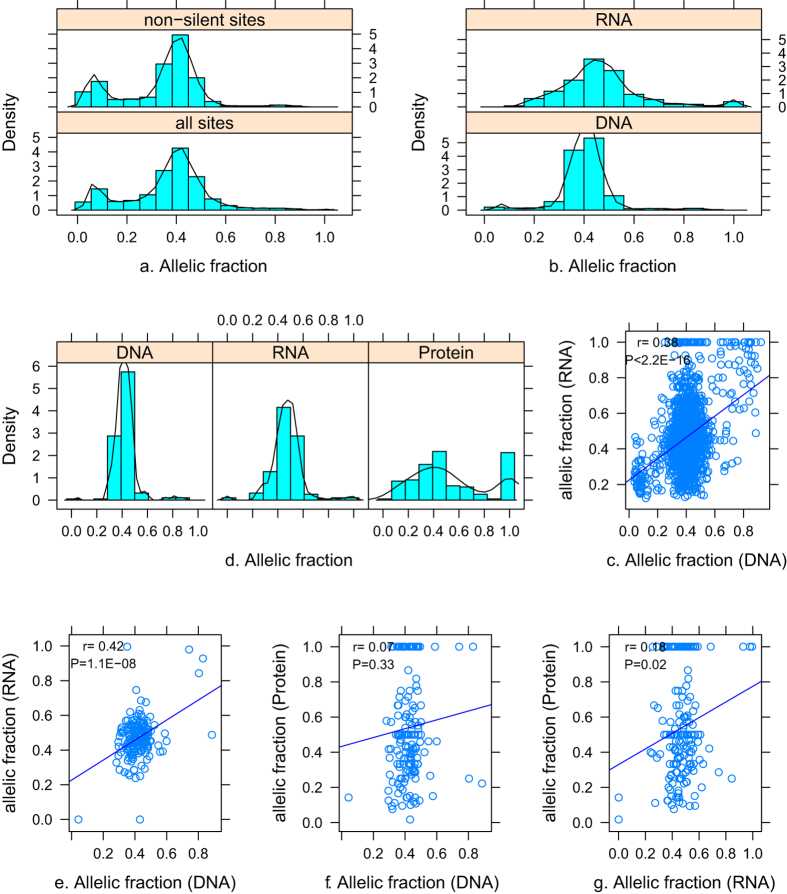
Distribution of the allelic fraction.(a) The allelic fraction of all identified somatic mutations (all sites) and non-silent sites identified by WES. The distribution of allelic fraction between all sites and non-synonymous sites differed significantly (Kolmogorov-Smirnov test, P < 2.2 × 10−16). For the transcribed tumor-mutated alleles, the distribution of the allelic fractions (b) and correlation (c) between mRNA and genome are shown (n = 2061). For translated tumor-mutated alleles, the distribution of the allelic fractions at the protein levels and the corresponding genome and transcriptome (n = 174) (d), and the correlation in any two of pairwise comparisons (e–g). The y-axis in a, b, and d is the probability density of allelic fraction.